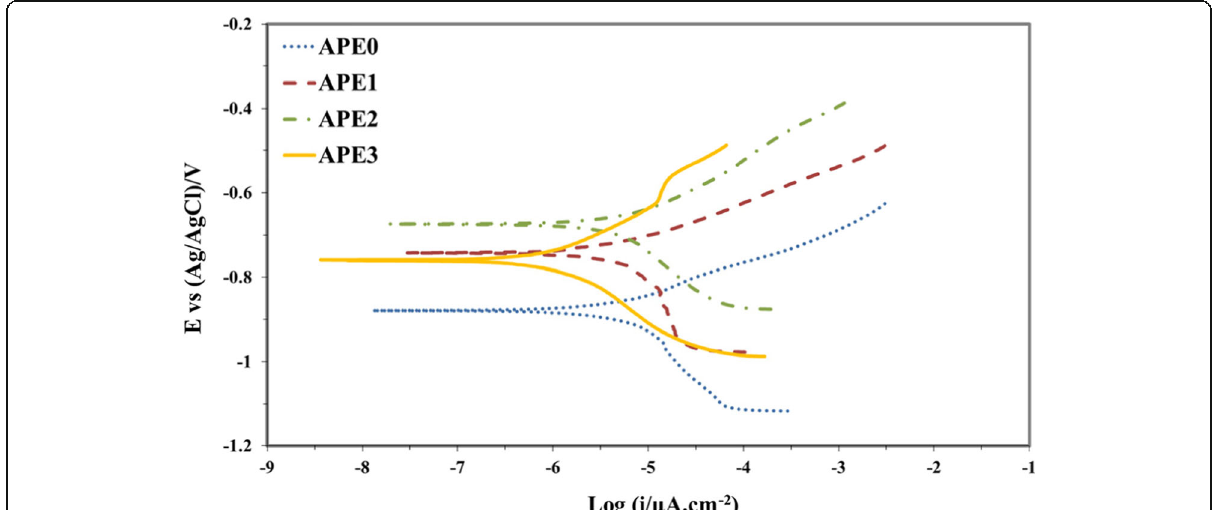
Fig. 3 Tafel polarization curves for steel samples after 7-day exposure to NaCl brine containing 0 to 3% (v/v) apple pomace extract